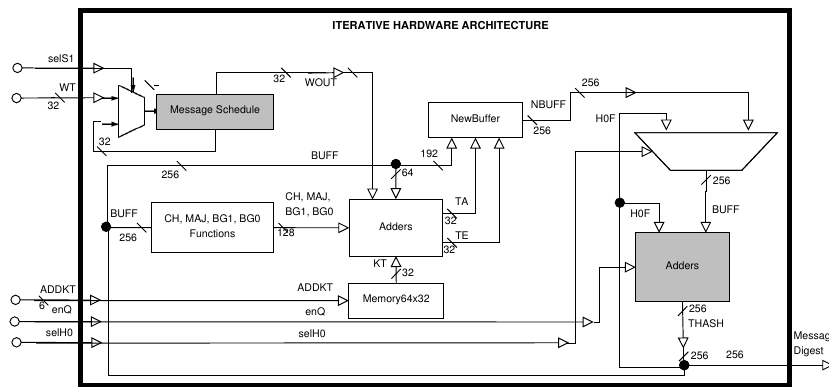
Figure 1. Iterative hardware architecture diagram without fault detection or pipeline structure.